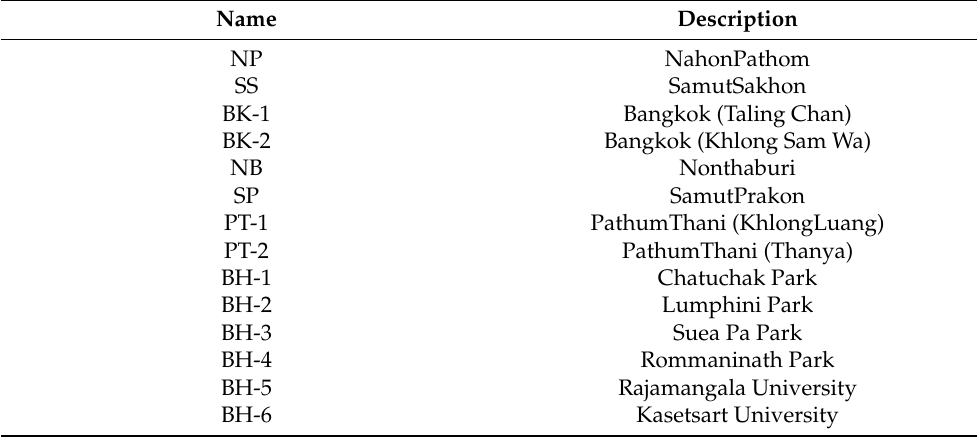
Table 2. Name and location of each bored hole on the map.